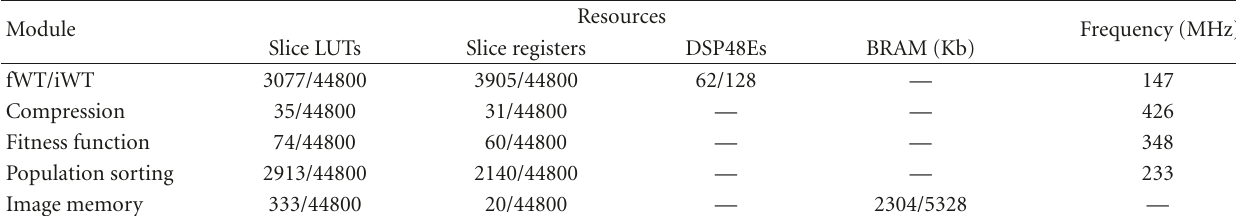
Table 16: Preliminary implementation results for the main modules in the